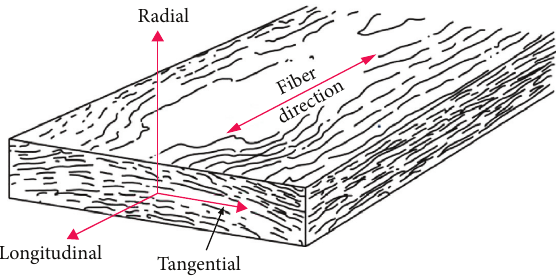
Figure 1: The main directions of orthotropy of wood